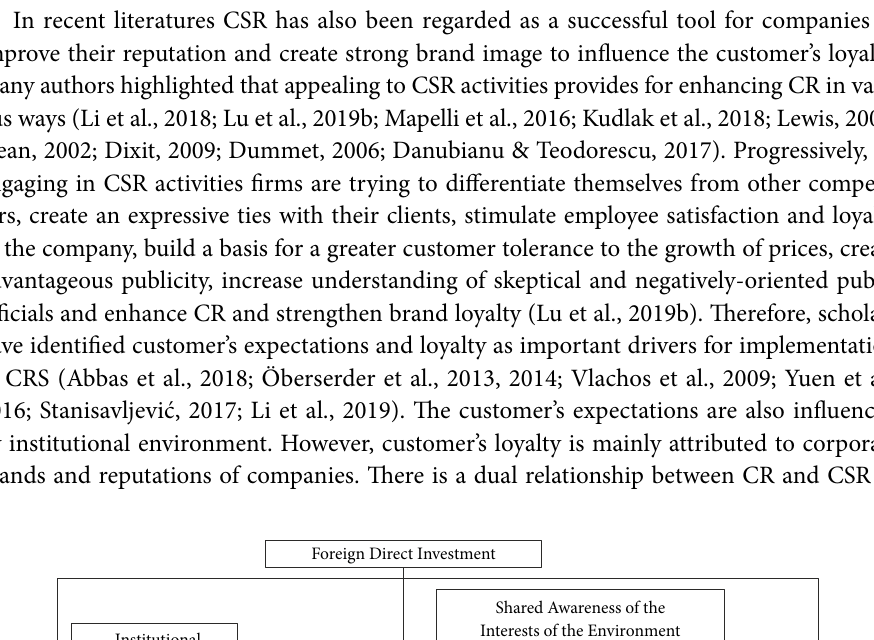
Institutional Framework